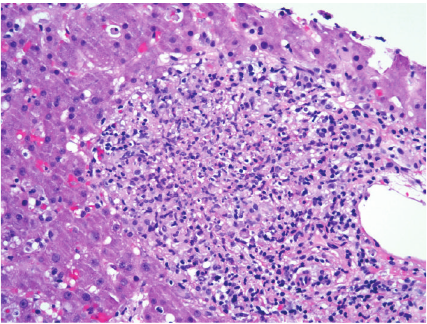
Figure 1: H&E staining of biopsy specimen showing hepatic granuloma in 20x magnification.